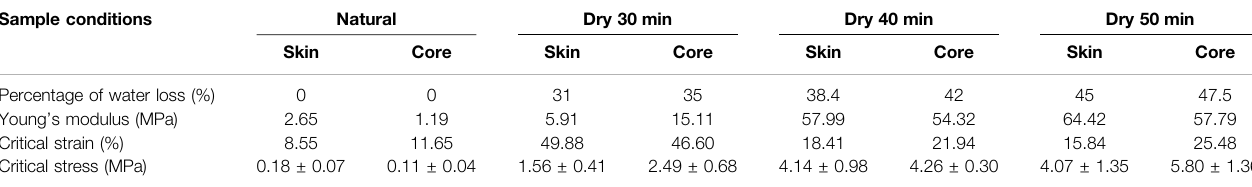
TABLE 4 | The main mechanical properties result of different conditions of Pleurotus eryngii . Sample